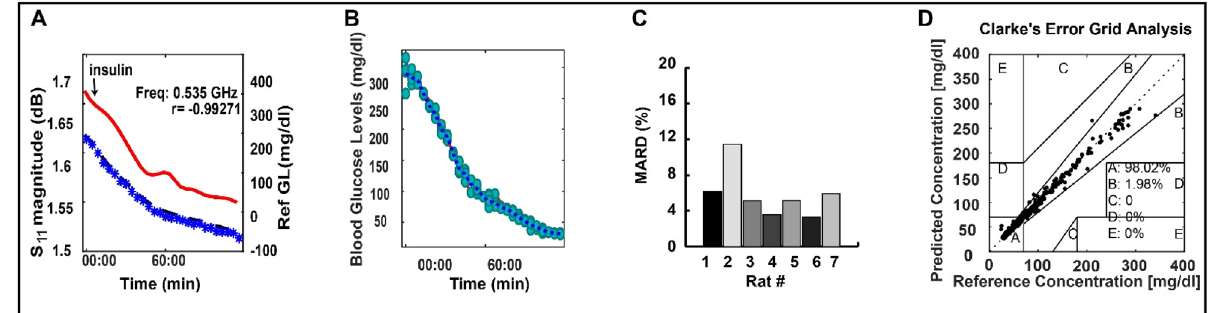
Figure 4. In-vivo detection of glucose levels in rats. ( A ) In-vivo experiment of one of the diabetic rat models showing the sensor’s raw S11 parameters. ( B ) Predicted glucose level. ( C ) The MARD for the experiments conducted on seven different rats. ( D ) CEG analysis for the seven experiments. Additional results are provided in the Supplementary Fig.